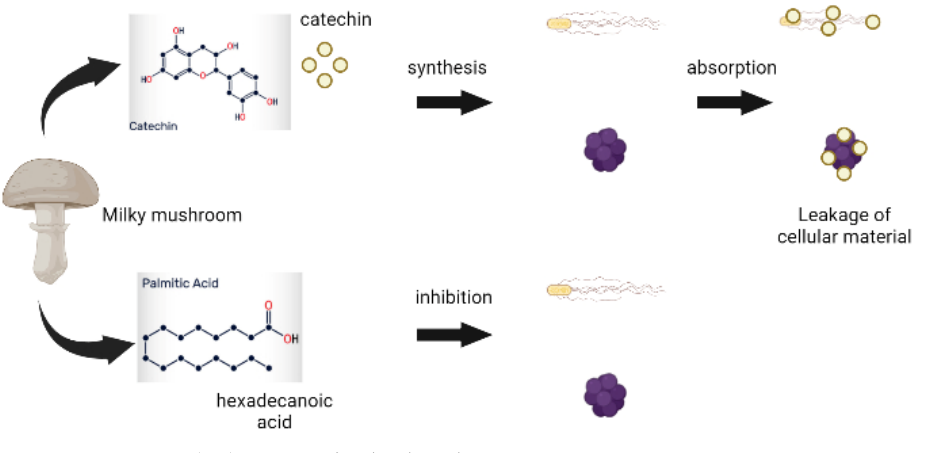
Figure 4. Antimicrobial activity of Calocybe indica .